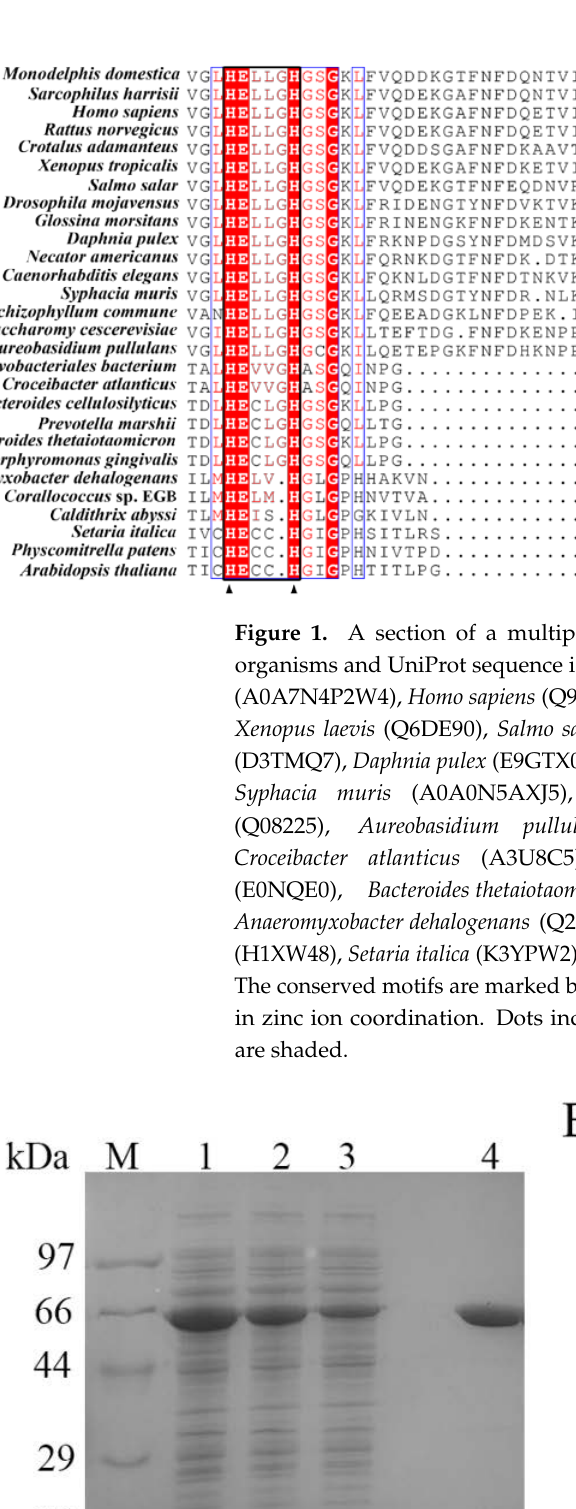
mass fingerprinting (PMF). Among the stained gel bands, three peptide fragments of a specific band were detected and shared 100% identity with the peptides of a hypothetical protein, COCOR_06584 (GenBank accession no. AFE07001.1) from C. coralloides DSM 2259 (Figure S1). Thereafter, the corresponding gene in Corallococcus sp. strain EGB was cloned; it contained a 1719 bp open reading frame encoding 572 amino acids, with a predicted signal peptide (residues 1 to 22). The molecular mass and pI were calculated to be 62.48 kDa and 7.9, respectively. The calculated molecular mass of Co DPP III was much higher than the molecular mass of the native protein. This was also the case for the identified AmyM from the supernatant, the molecular mass of calculation and native protein of which was 55.5 kDa and 43 kDa, respectively [41]. In view of the reports regarding various proteases from myxobacteria, the smaller molecular mass of the native protein might have been caused by proteolytic cleavage. The BLASTP analysis showed that the deduced amino acid sequence shared high identity (>50%) with that of the hypothetical protein, the DNA mismatch repair protein MutT, and the peptidase family M49 in the genome of several myxobacteria. Among the characterized enzymes, the amino acid sequences shared a higher identity with the members of the peptidase family M49, such as Nudix hydrolase 3 from Arabidopsis thaliana (32%), DPP III from Caldithrix abyssi ( Ca DPP III, 42.5%), Bacteroides thetaiotaomicron ( Bt DPP III, 14.3%), human ( h DPP III, 13.7%), and Saccharomyces cerevisiae ( y DPP III, 12.7%). Although it shares a higher identity to Nudix hydrolase 3, it was shown that Co DPP III lacks the N-terminal Nudix box (GX 5 EX 7 REUXEEXGU). Multiple alignments of the primary sequences revealed that the deduced amino acid sequence retains the conserved